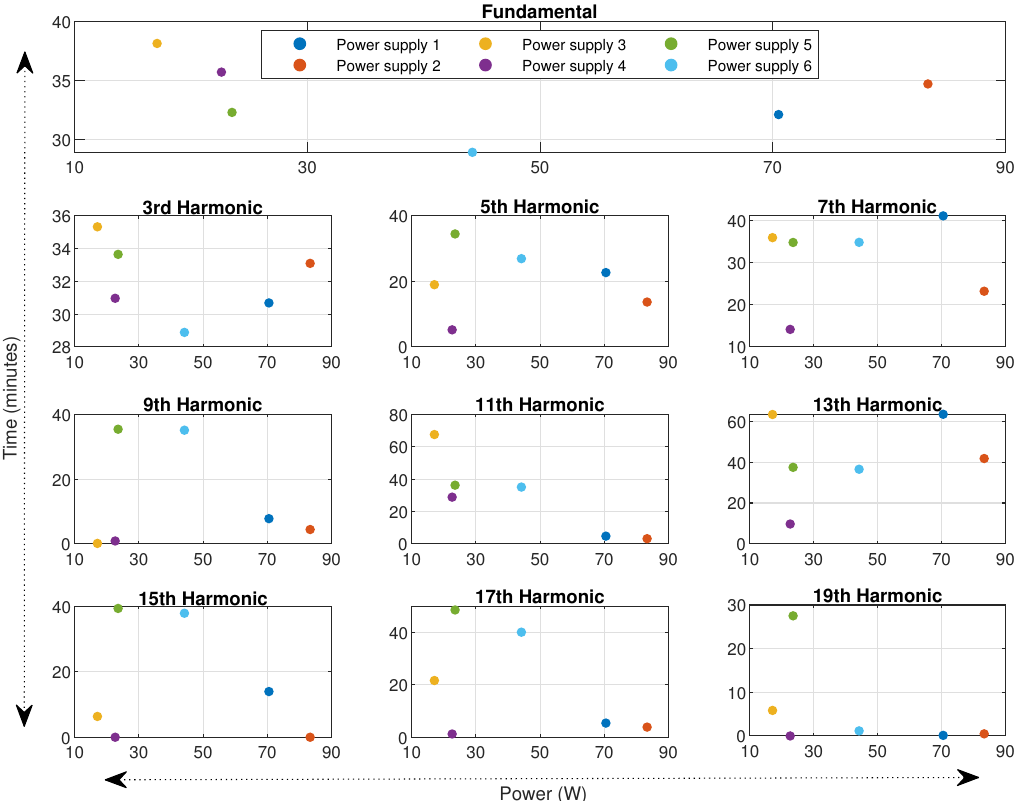
Figure 8. Current harmonic stability time ( T stable ) variation against active power of all SMPS.